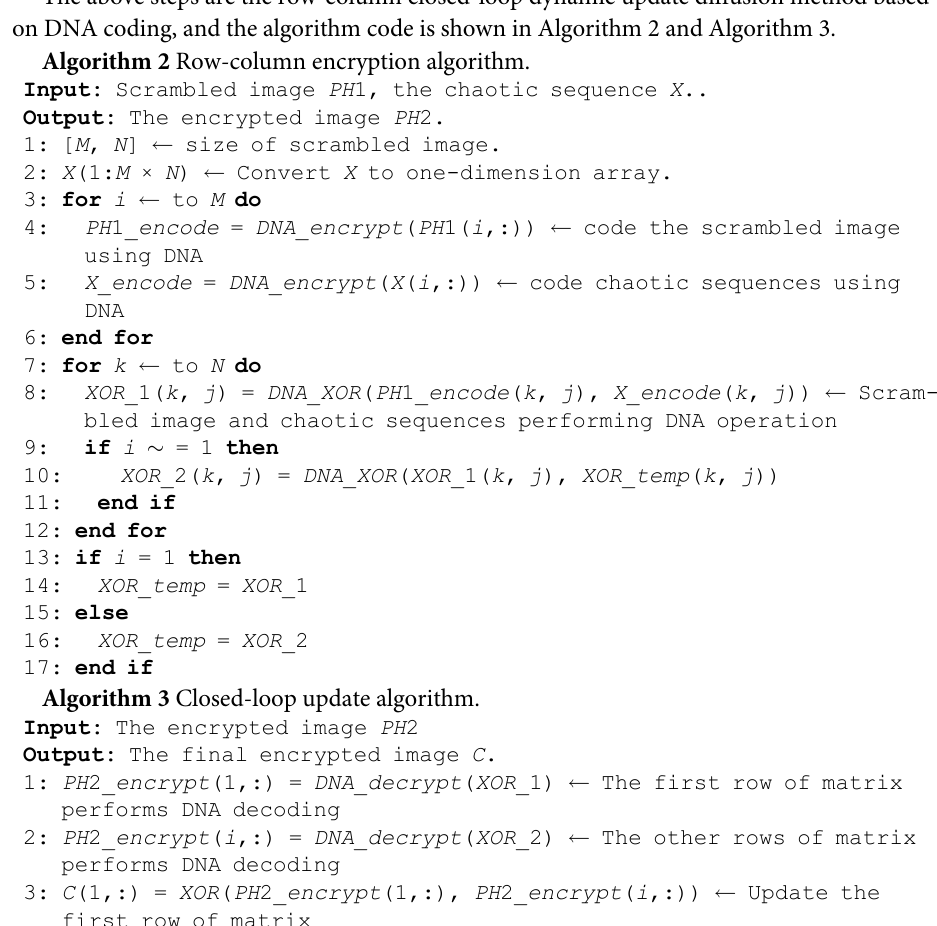
Algorithm 2 Row-column encryption algorithm.